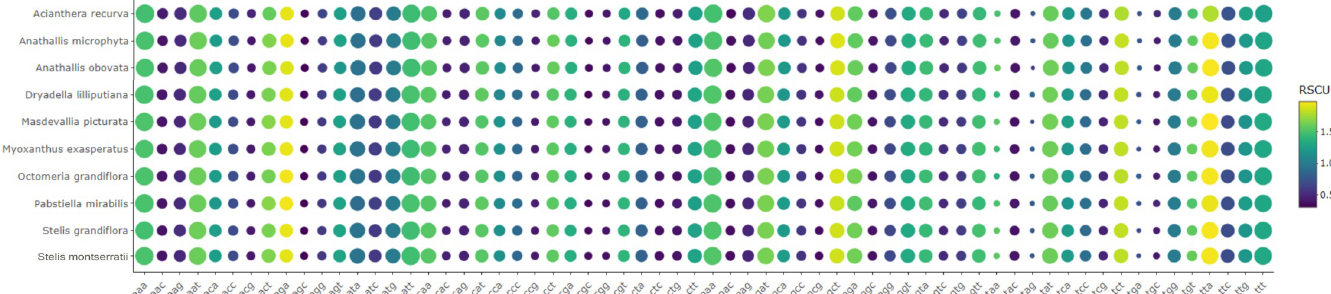
Fig 2. Heatmap of relative synonymous codon usage (RSCU) and codon relative frequency observed for Pleurothallidinae CDSs. The lowest frequency is indicated by purple and highest yellow. Relative frequencies are proportional to circle sizes.